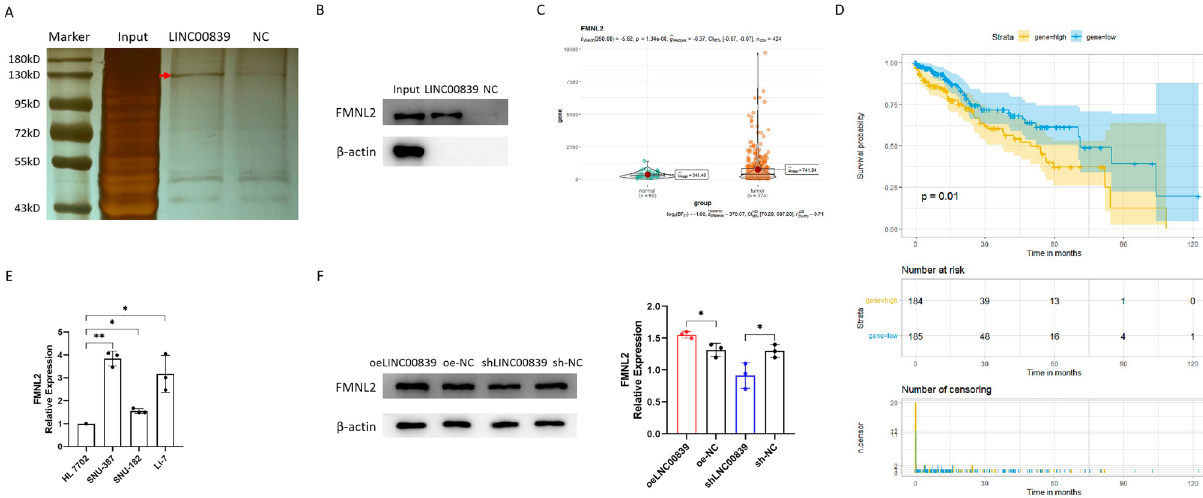
Figure 6. LINC00839 up-regulates the protein expression level of FMNL2. ( A ) The protein samples were separated via SDS-PAGE followed by silver staining. The lacZ gene was used as NC. A specific band was identified in the LINC00839 group and was marked with an arrow. ( B ) The protein samples were examined using WB. ( C ) The expression of FMNL2 in liver cancer samples and normal samples. ( D ) The correlation between FMNL2 levels and patient OS. ( E ) The relative expression of FMNL2 in liver cancer cell lines and normal liver cell line. ( F ) The protein expression levels of FMNL2 in the oeLINC00839 group, oe-NC group, shLINC00839 group, and sh-NC group. The original WB results with markers were shown in Supplementary File 1. The experimental data was represented by mean ± SD from at least three independent experiments. * P < 0.05, ** P < 0.01.